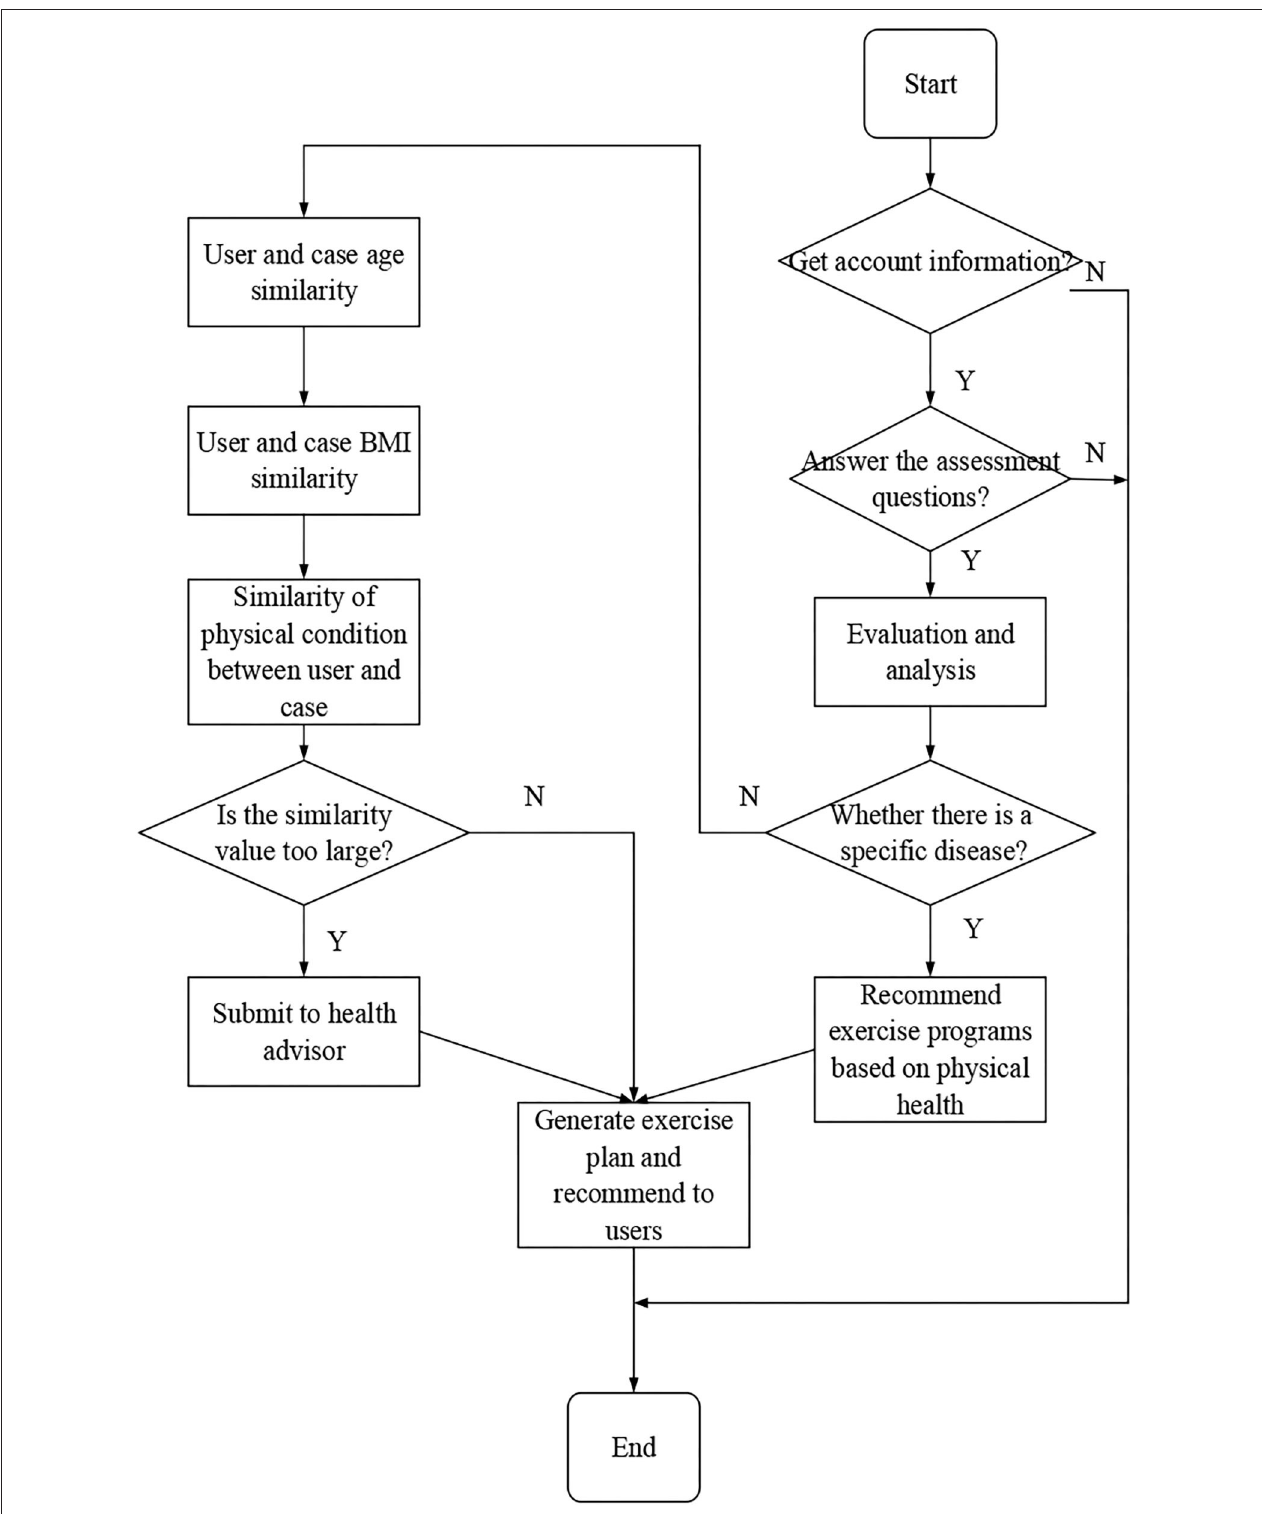
FIGURE 6 | Flow system of sports scheme making and recommendation